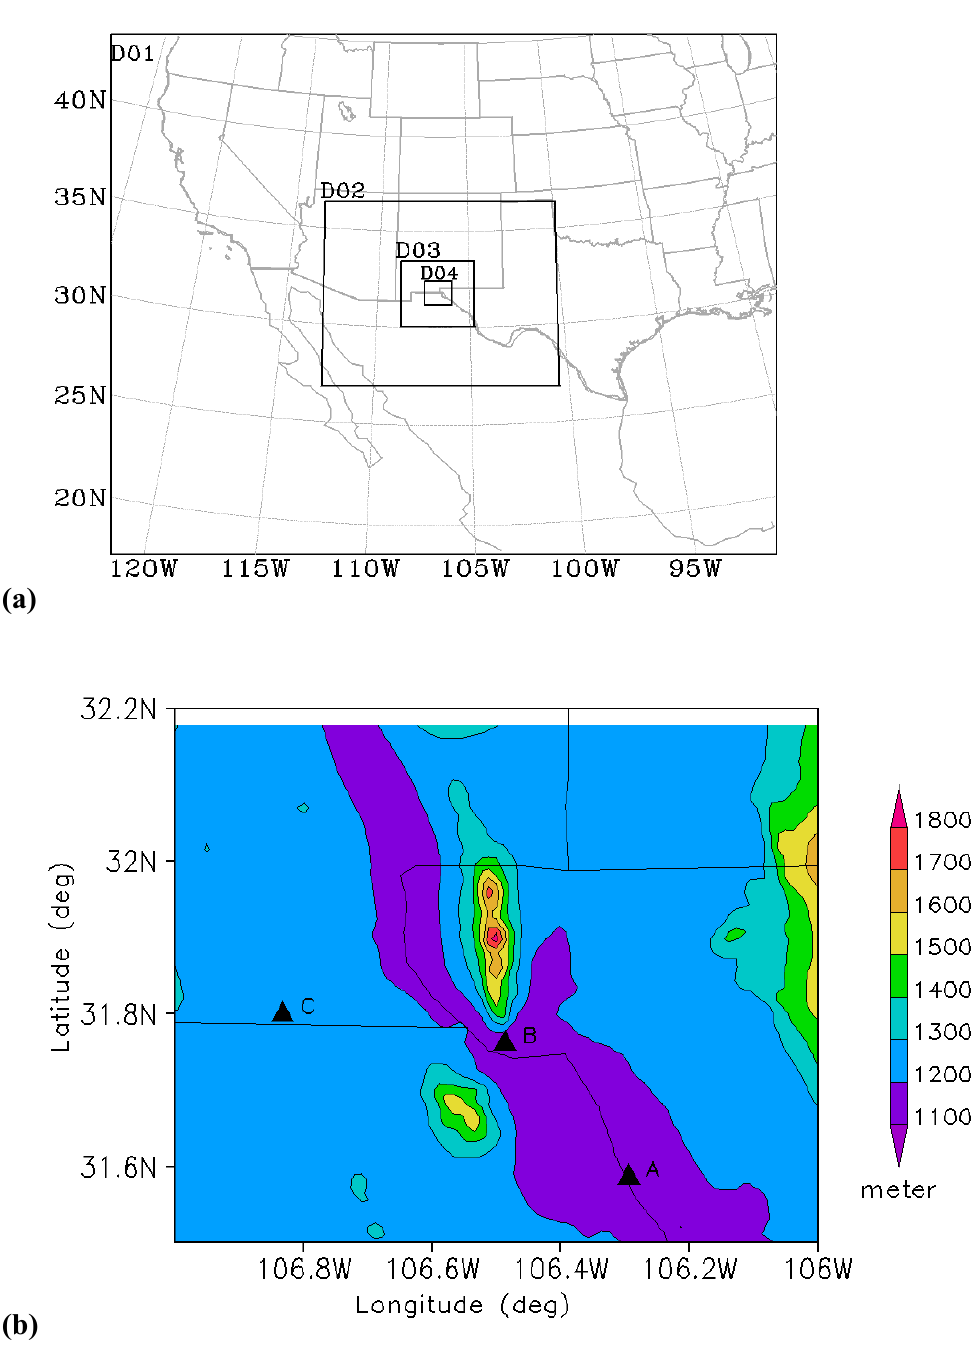
Figure 1. (a) Nested domains used for WRF, SMOKE and CMAQ models. D01, D02, D03 and D04 are the outer, middle and fine domains with the grid distances of 36 km, 12 km, 4 km and 1 km respectively. (b) Fine domain (1km) topography (meters). Three points are selected, and Point B is the location of downtown El Paso. The northern high topography area is the Franklin Mountains and its counterpart to the south is the Juarez Mountains. The Rio Grande River valley runs between these two mountains through El